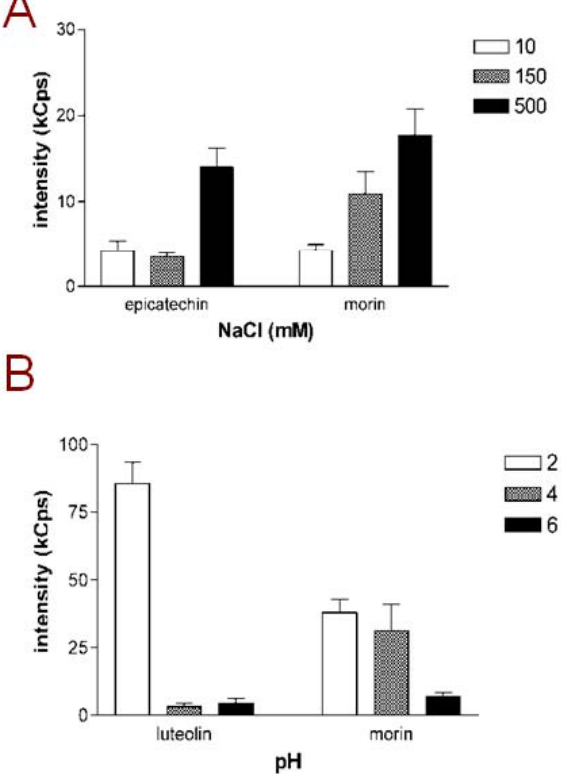
Figure 1. Aggregating behavior of flavonoids is dependent on buffer